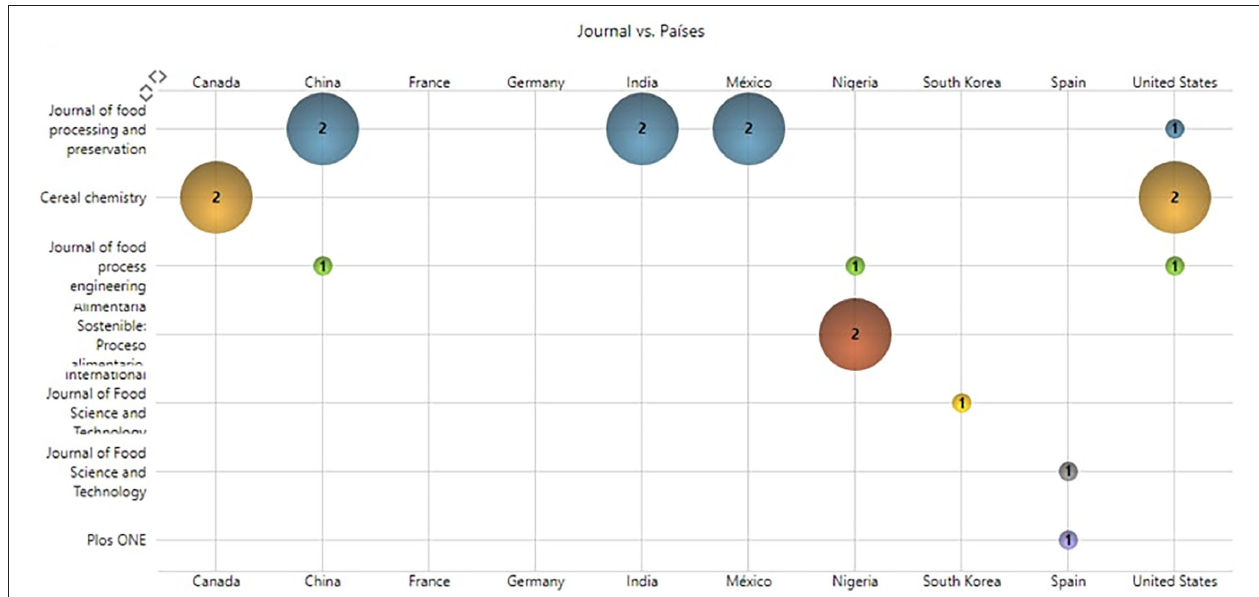
FIGURE 2 | Journal vs. countries of origin of the paper. Source: Vantage point software (through information provided by the authors).